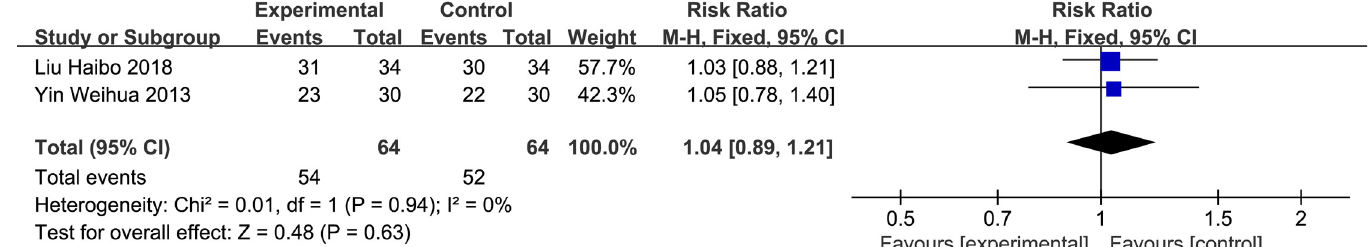
PLOS ONE | https://doi.org/10.1371/journal.pone.0266754 June 27,